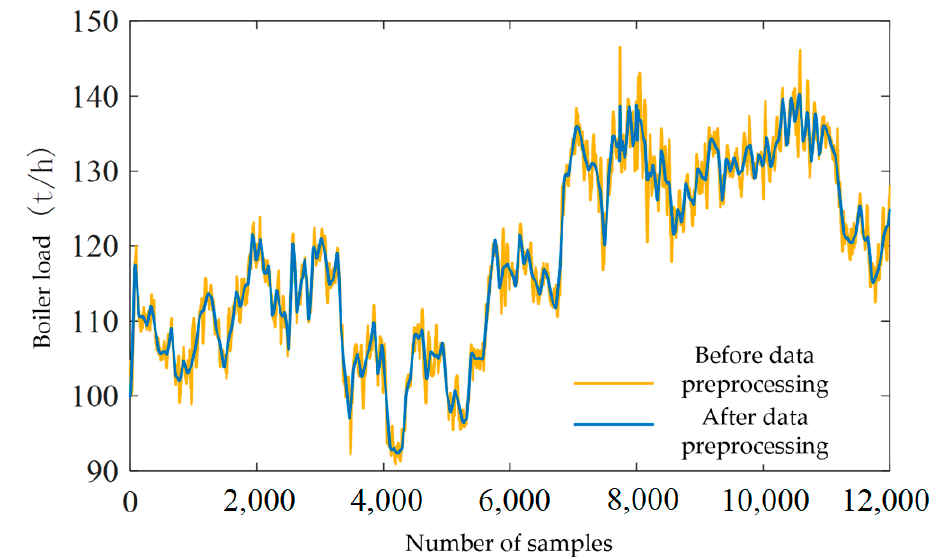
Figure 5. The result of data preprocessing.